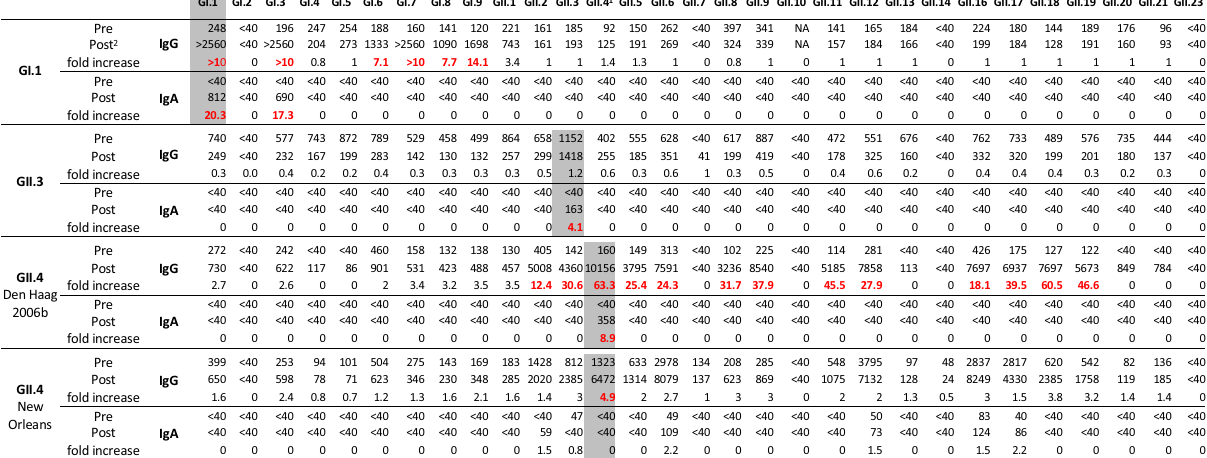
Table 1. IgG and IgA titers against P particles in pre- and post-infection sera. Marked in red are the titers that were ≥ 4-fold increased in post-infection sera compared to pre-infection sera. Shaded in grey are the antibody responses against the homologous infecting genotypes. Antibody responses against the non-structural proteins are listed in supplementary table